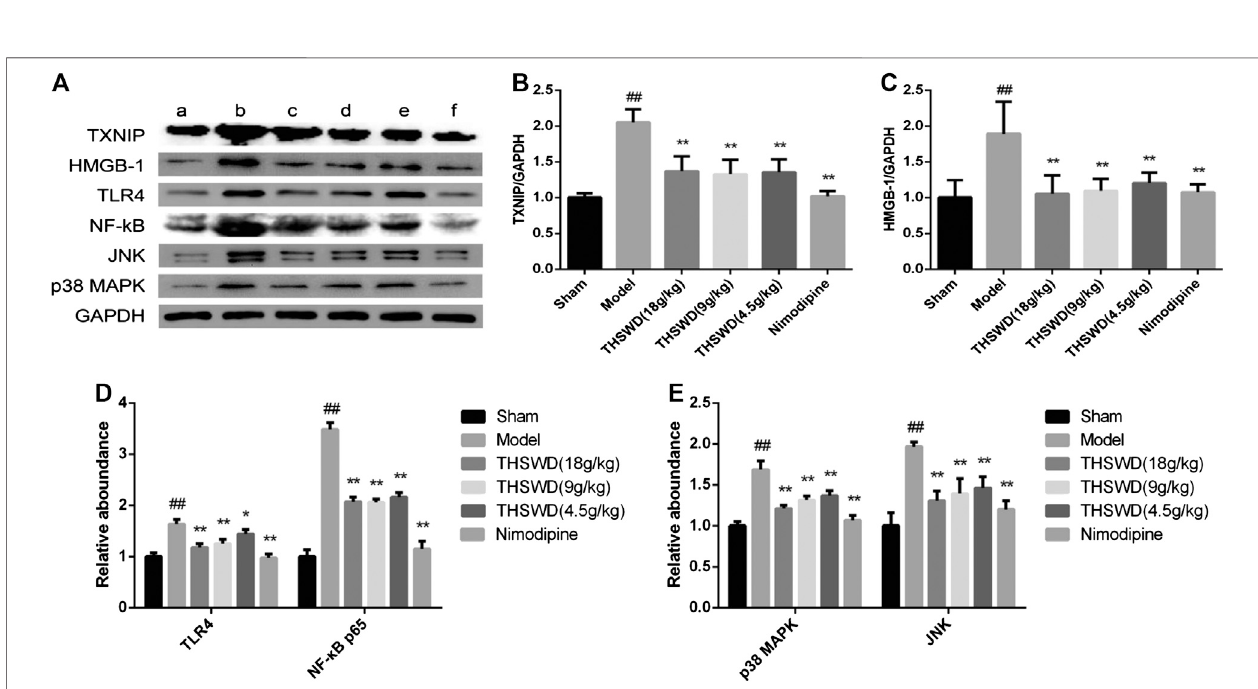
FIGURE6| EffectofTaohongSiwudecoction(THSWD)onthepathwaysofregulationofpyroptosisinmiddlecerebralarteryocclusion-reperfusion(MCAO/R)rats. (A) Photographs of western blots, (B) TXNIP, (C) HMGB-1, (D) toll-like receptors-NF κ B, (E) MAPK. a: Sham, b: Model, c: THSWD (18 g/kg), d: THSWD (9 g/kg), e: THSWD(4.5 g/kg), f: nimodipine.Theresultswerepresentedasthemean ± SD( n (cid:2) 3).Comparedwithshamgroup, # p < 0.05, ## p < 0.01.Comparedwithmodelgroup, * p < 0.05, ** p <